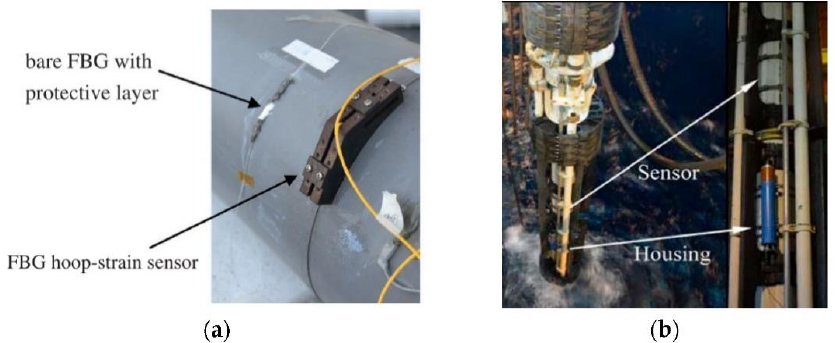
Figure 9. ( a ) Photograph of FBG hoop strain sensors that are wrapped around a pipe. ( b ) Field demonstration of the sensors based on FBG that monitor the riser stress for subsea drilling and op- erations [71].